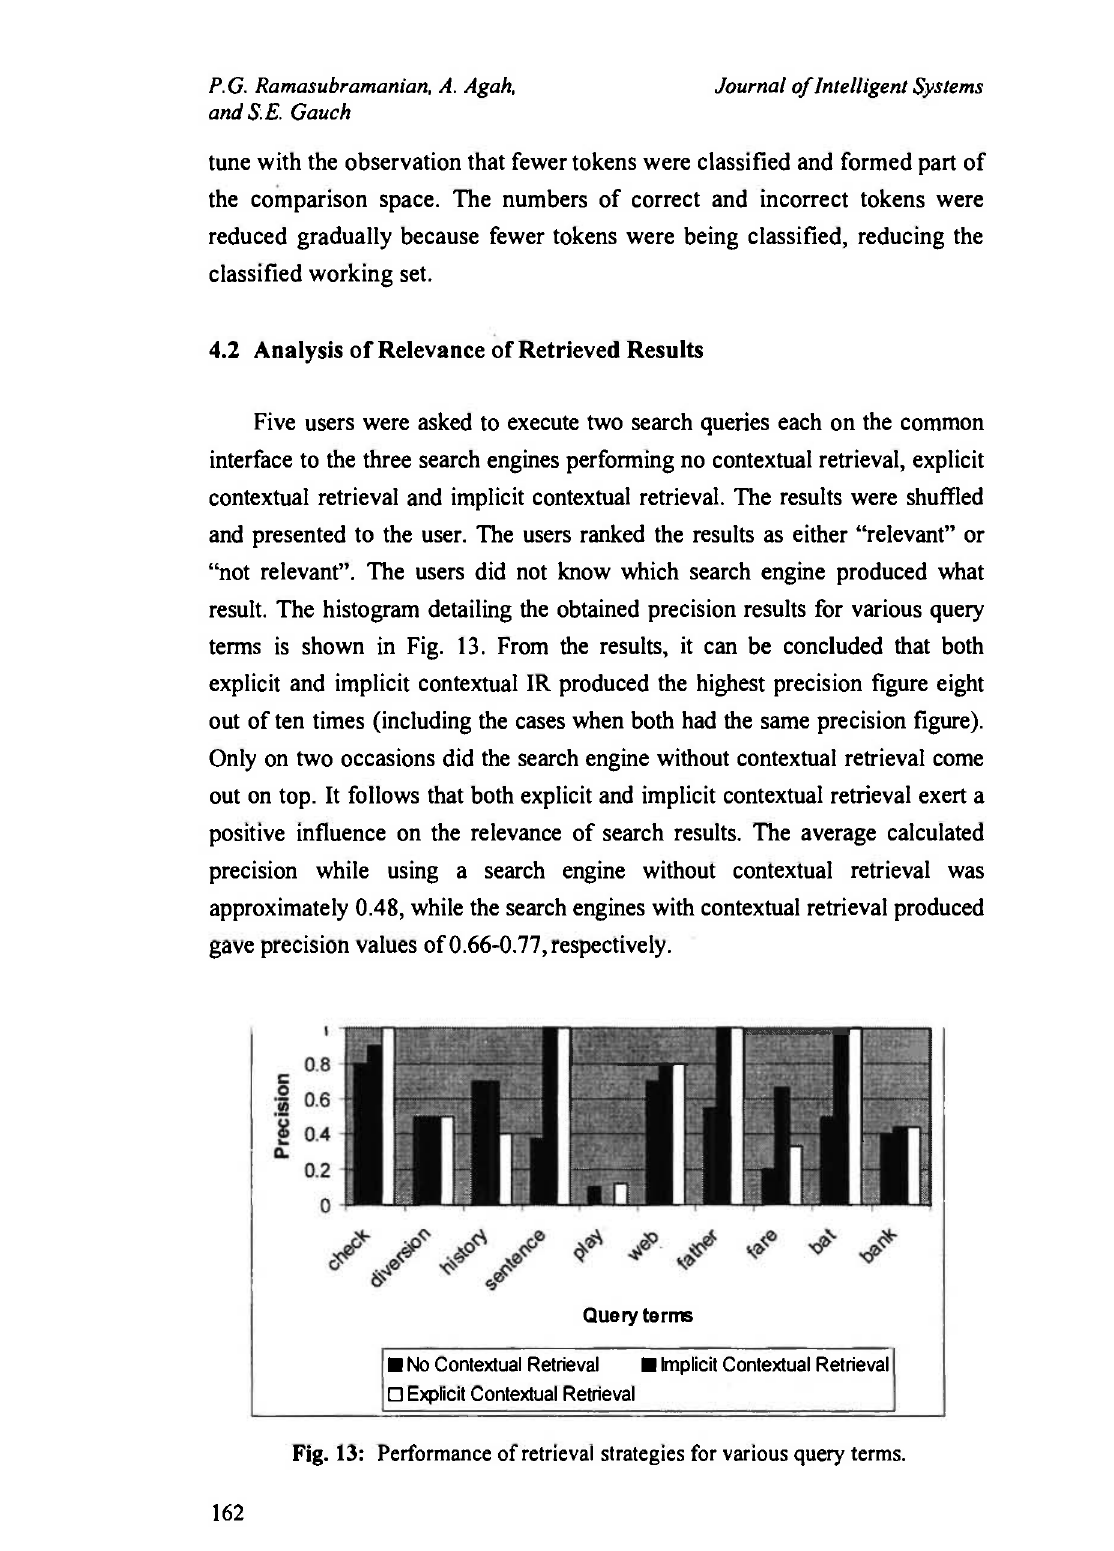
Fig. 13: Performance of retrieval strategies for various query